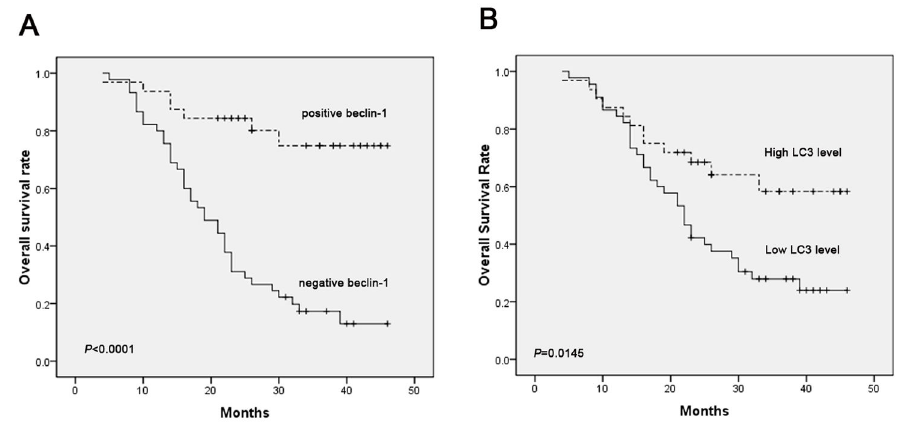
Figure 3. Kaplan-Meier curves for beclin-1 and LC3 expression in 82 patients with hypopharyngeal squamous cell carcinoma (HSCC)